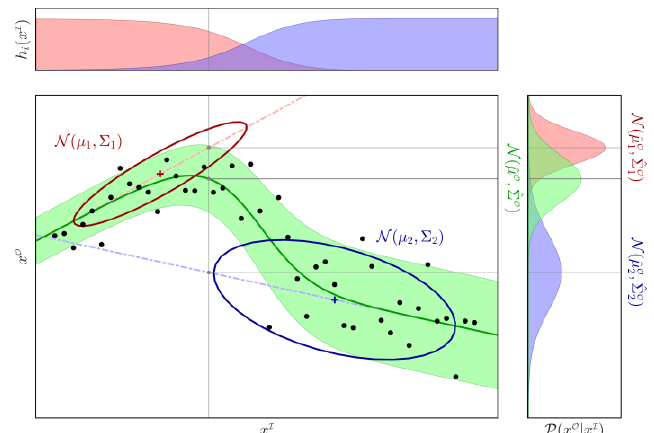
Figure 7. An example of GMR combined with GMM consisting of two Gaussians. The x I and x O are the 1D input and output (Adapted from [29]).